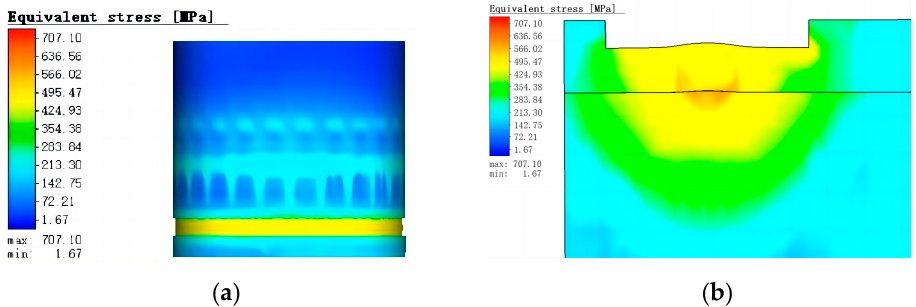
Figure 9. Results of equivalent stress simulation: ( a ) Simulation results of overall equivalent stress; ( b ) simulation results of equivalent stress of weld section.